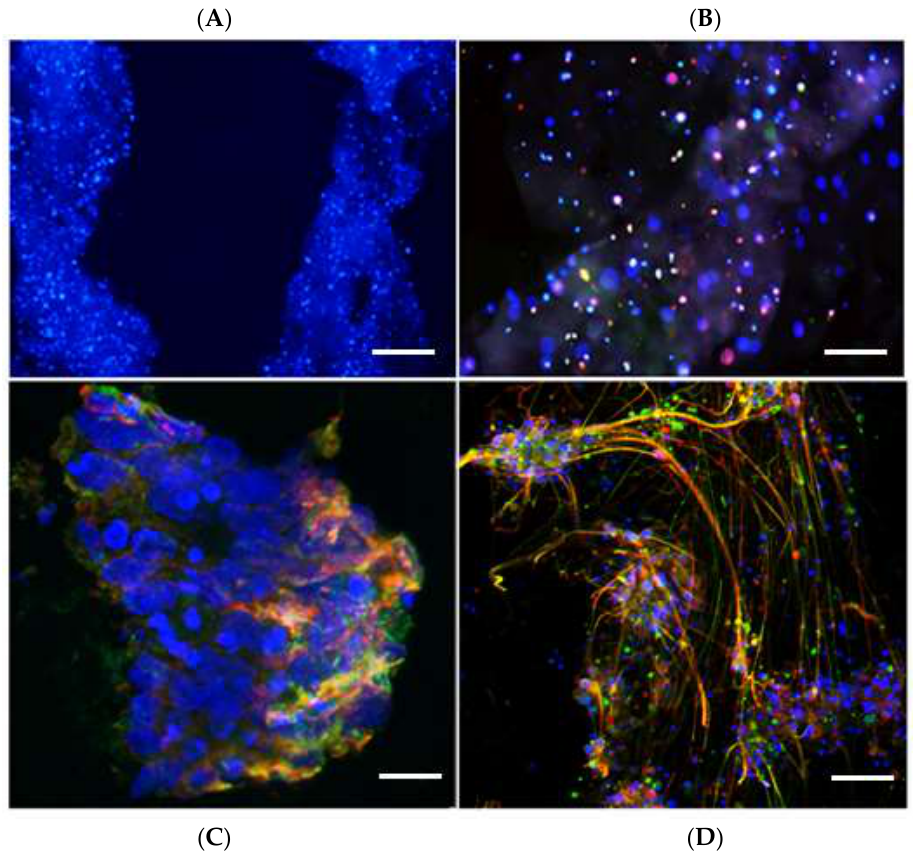
Figure 7. Immunofluorescence labeling of iPSC-derived neural cells after 1 week and 3 weeks of culture inside the scaffold ( A , B ) and on the surface of scaffold ( C , D ). Sections are labelled with antibodies to bTUB (green) and GFAP (red), and stained with Hoechst (blue). ( A ) Cells are distributed throughout the scaffold. ( B ) Inside the scaffold, the cells express neural markers, but do not extend processes. ( C ) In the peripheral part of the scaffold, after 1 week in culture, there are differentiated neurons and astrocytes on the surface of the scaffold. ( D ) After three weeks in culture, there is extensive neurite formation from neurons, intermingled with astrocytic processes on the surface of the scaffolds. Scale bar: A=20 microns; B= 10 microns; C=5 microns; D=10 microns.